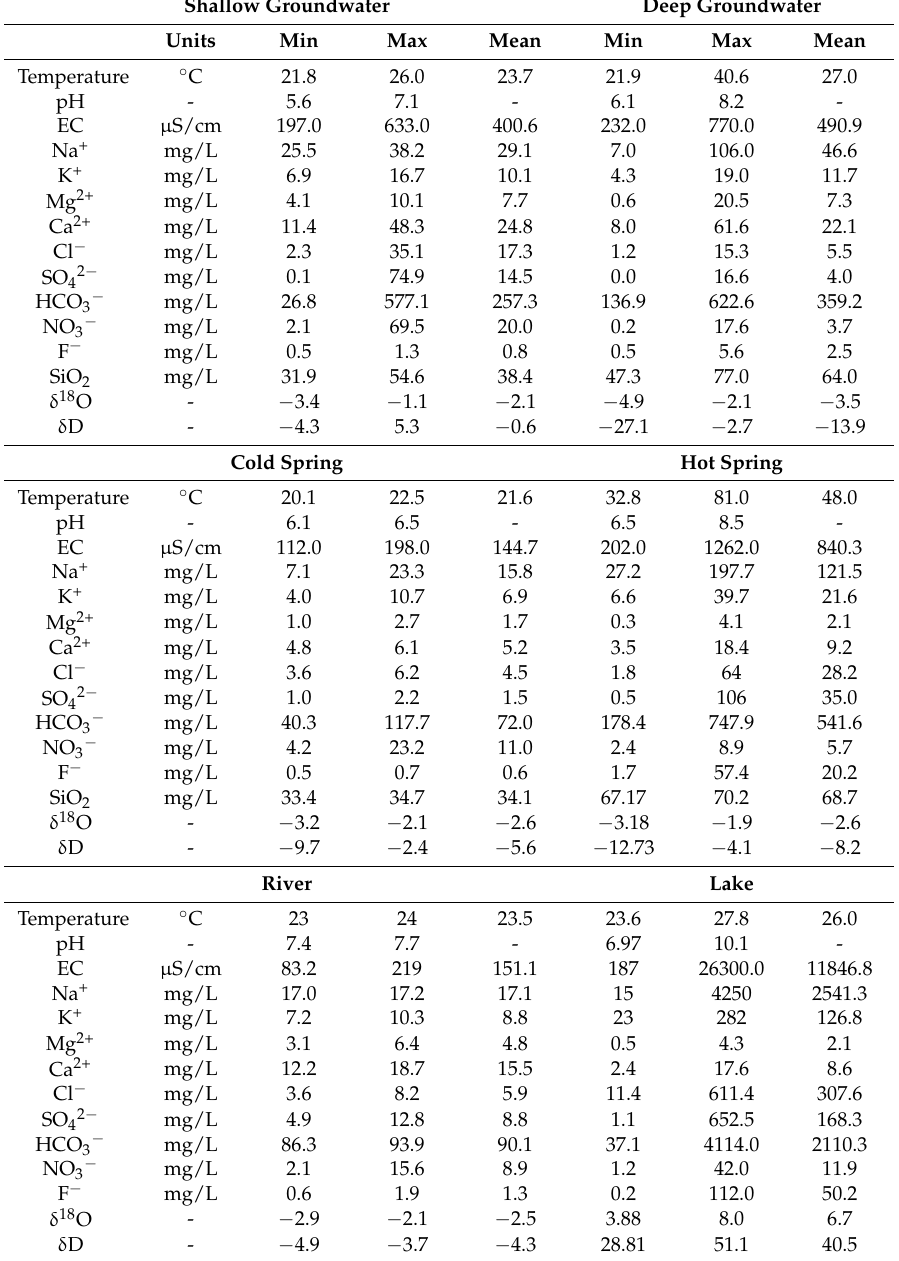
Table 1. Statistical summary of hydrochemical components in the study